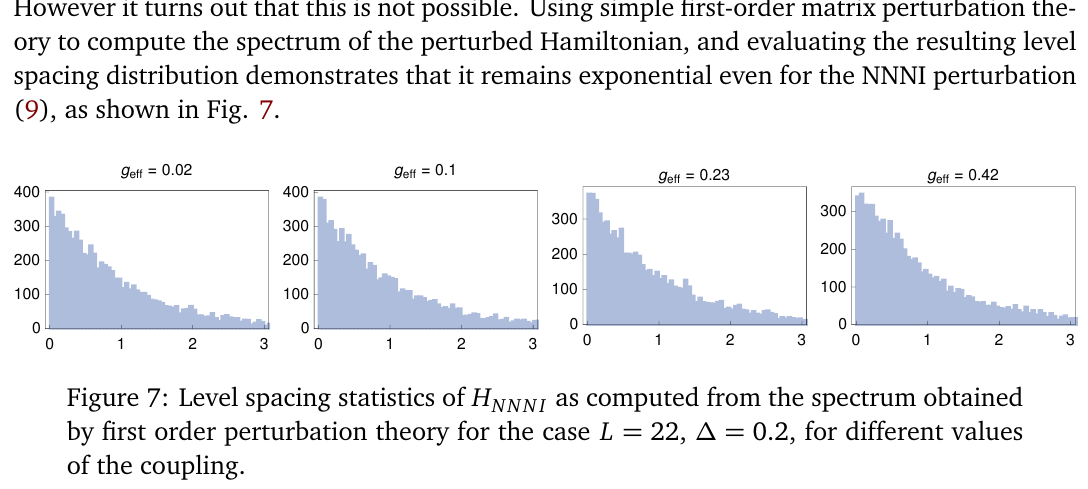
as computed from the spectrum obtained NNNI